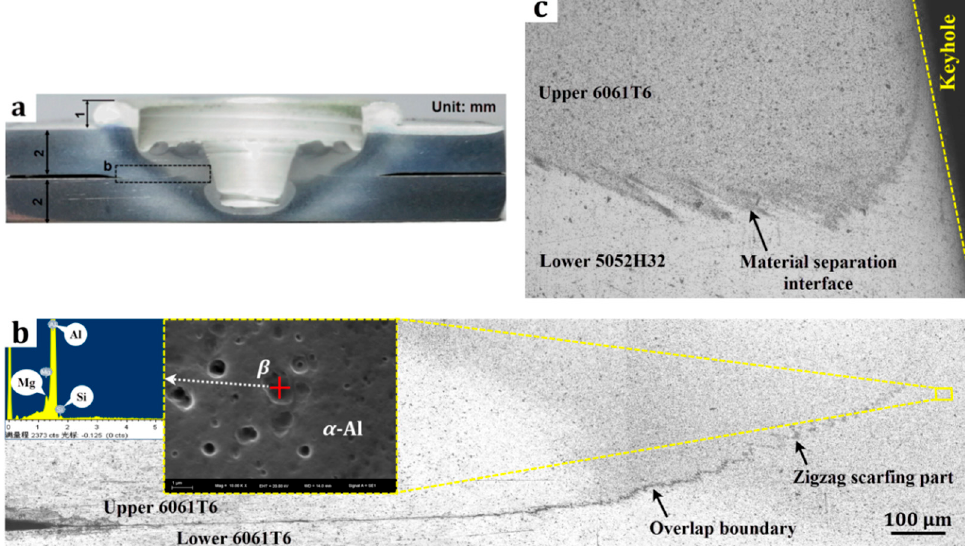
Figure 4. Microstructural investigation of FSSW joints with similar and dissimilar materials. ( a ) The bonding cross-sectional interface; ( b ) Post-weld microstructure adjacent to the lap plane and its Energy Dispersive Spectroscopy (EDS) result for a similar 6061 joint; ( c ) Modified microstructure of the bonded region of a dissimilar 6061 and 5052 joint.